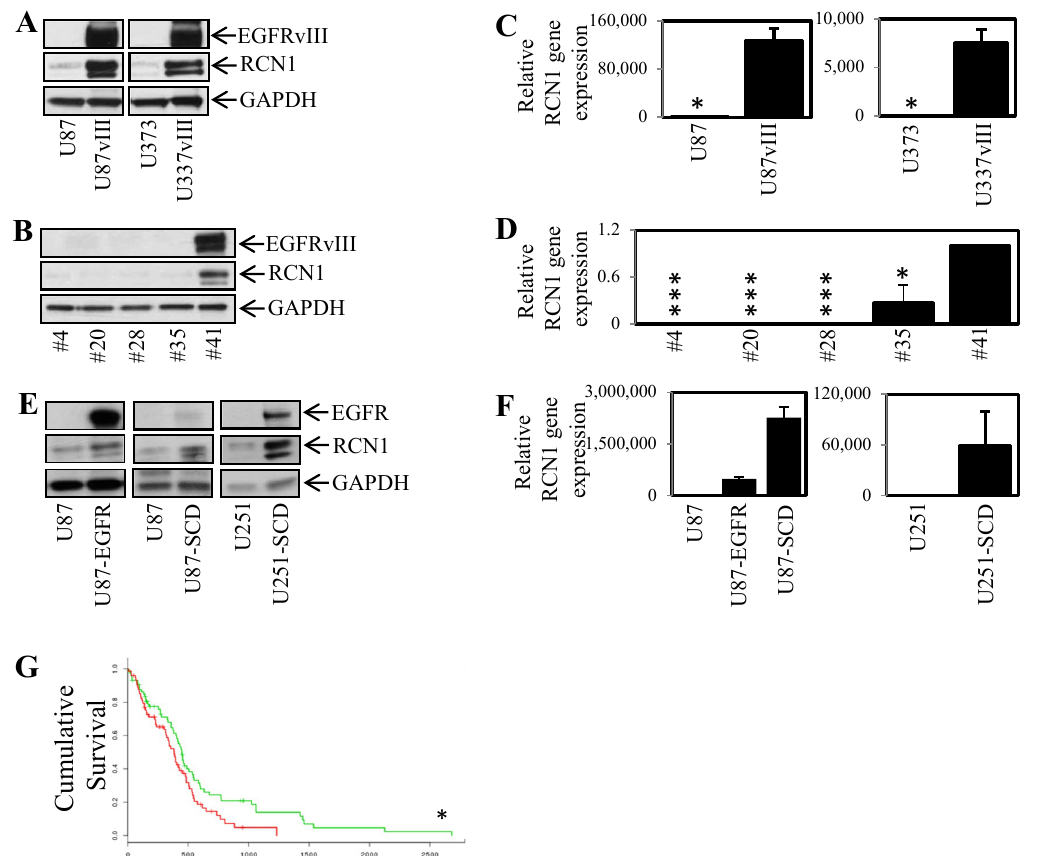
Figure 2. EGFRvIII expression correlates with RCN1 expression in glioblastoma cell lines. ( A , B ) . A series of EGFRvIII positive and negative glioblastoma cell lines were lysed and assessed for EGFRvIII, RCN1 and GAPDH expression by Western blot. ( C , D ) The same cell lines as above were assessed for RCN1 gene expression by qPCR. Three cell lines with variant sub-populations with differing EGFR expression were ( E ) lysed and assessed for EGFR, RCN1 and GAPDH expression by Western blot and ( F ) RCN1 gene expression by qPCR. ( G ) The relationship between high (Red) and low (Green) EGFR and RCN1 gene expression with patient survival was determined through mining a SurvExpress TCGA dataset. Kaplan – Meier survival curves were evaluated from the TCGA, n = 148. * p < 0.05; *** p < 0.001.